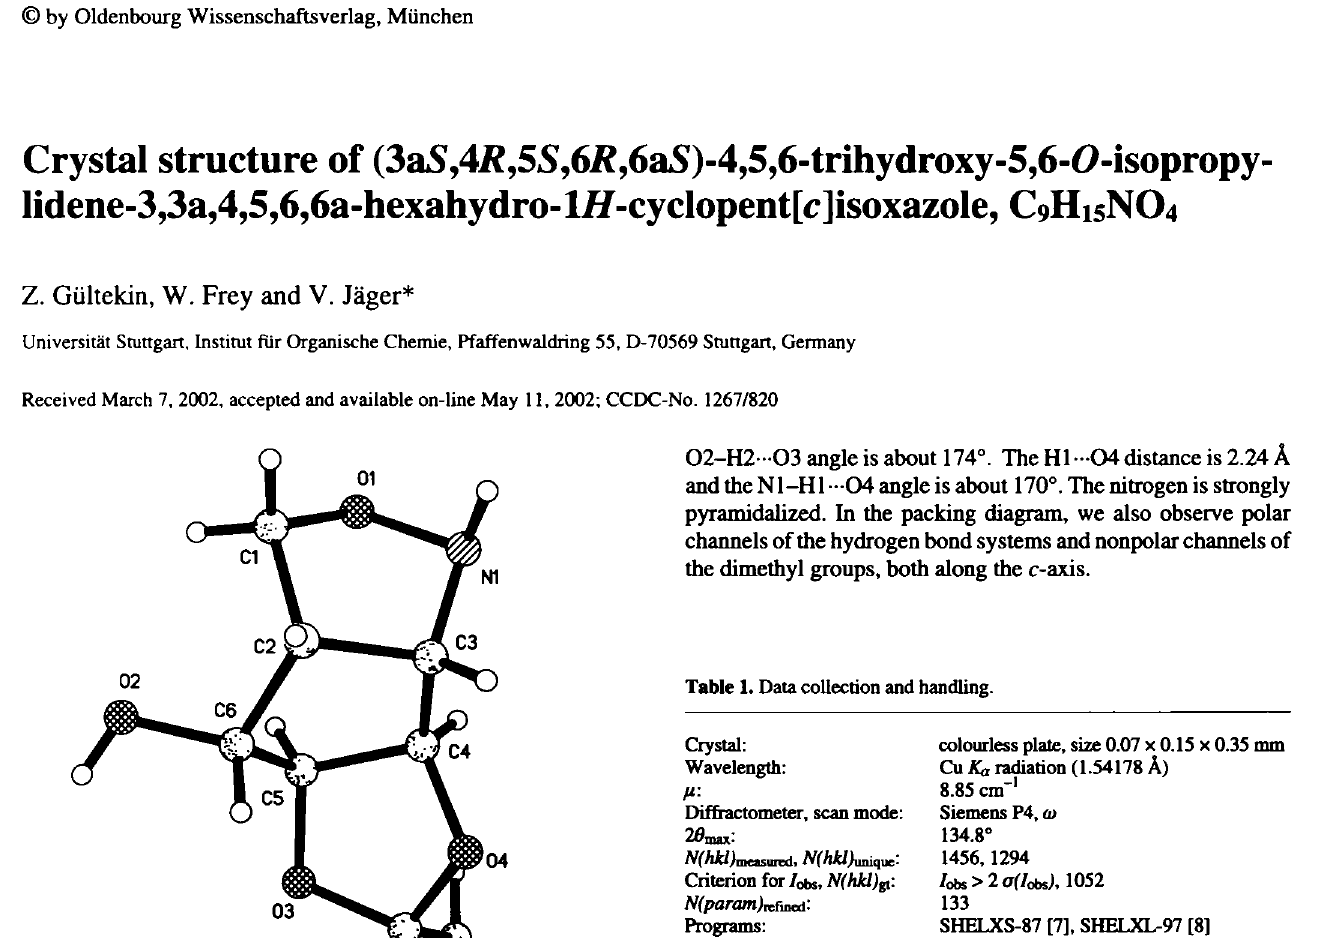
Table 2. Atomic coordinates and displacement parameters (in Â 2